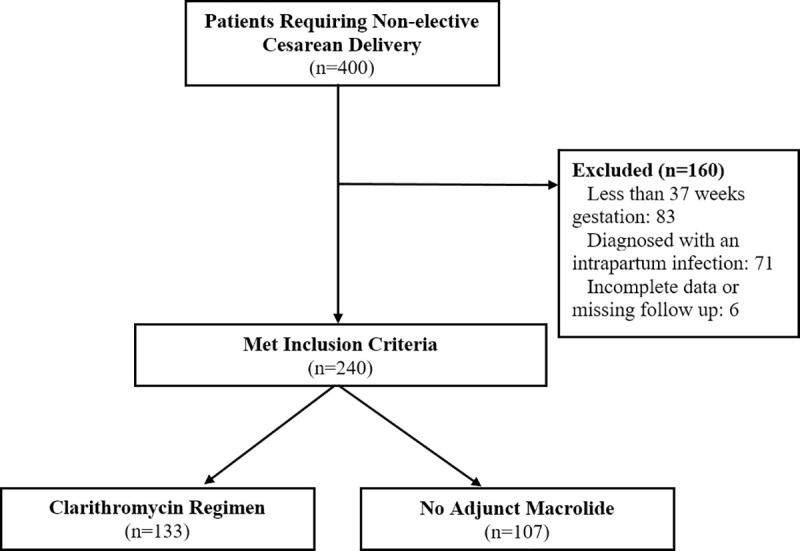
Study enrollment.A total of 400 patients were identified as requiring non-elective cesarean deliveries. 83 patients were excluded because they had pregnancies less than 37 weeks gestation at time of surgery. 71 patients were excluded because they received antibiotics apart from standard surgical prophylaxis due to intrapartum infection (43 patients intraamniotic infection/inflammation, 13 pyelonephritis, and 15 unspecified infections). 6 patients were excluded because of missing follow up information or incomplete data. No patients met any of the other exclusionary criteria.